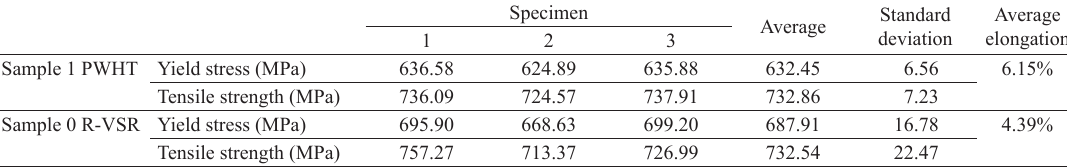
Table 9. Tensile test result for samples relieved by PWHT and